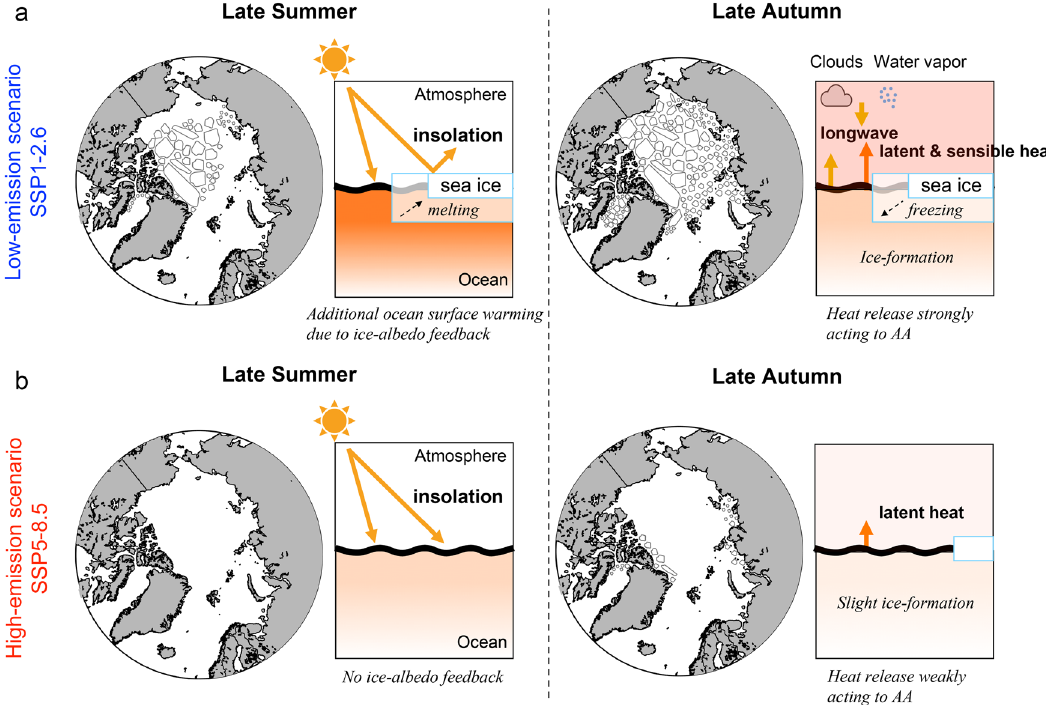
Fig. 4 Mechanisms for the enhanced AA in the low-emission scenario. a , b , Schematic diagram illustrating mechanisms for AA, which is scaled by the global-mean SAT change, under SSP1-2.6 and SSP5-8.5, respectively, in 2080 – 2099. In the low-emission scenario of SSP1-2.6, sea ice still exists, and the ocean surface warming results in the sea-ice retreat causing increased shortwave absorption at the open water and further warming (ice-albedo feedback) in late summer (left). In late autumn (right), the accumulated heat in the surface ocean is released to the atmosphere, enhancing the surface and atmospheric warming in the Arctic. In the high-emission scenario of SSP5-8.5, ice-albedo feedback is nearly absent due to the no-ice condition in late summer (left). In late autumn (right), small upward latent heat fl ux results in weak atmospheric warming and slight sea-ice